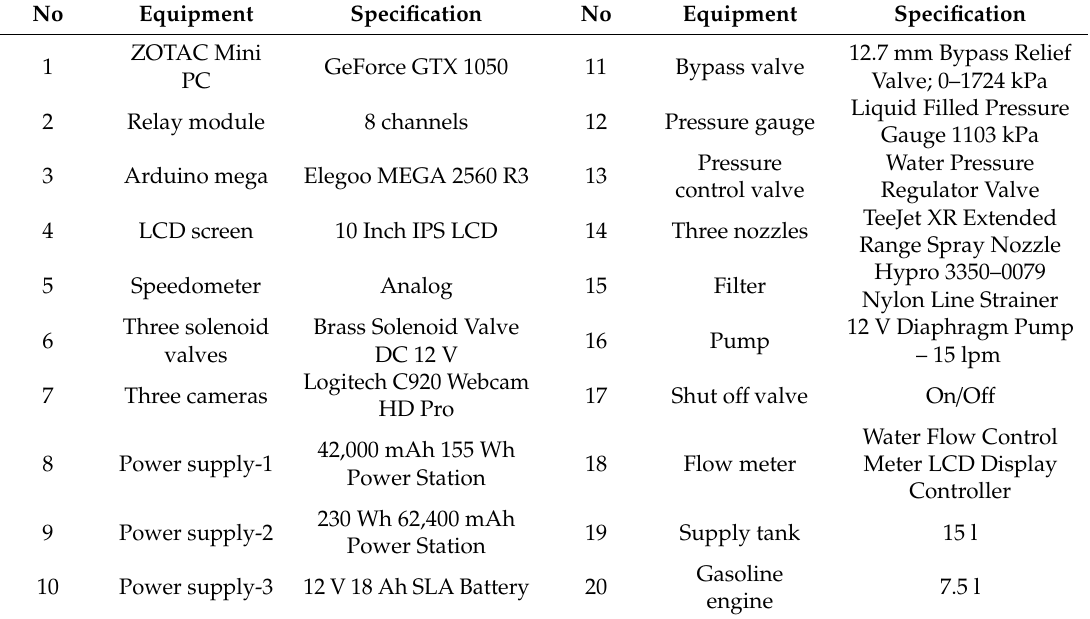
Table 1. The types of equipment used in a smart variable rate sprayer with their